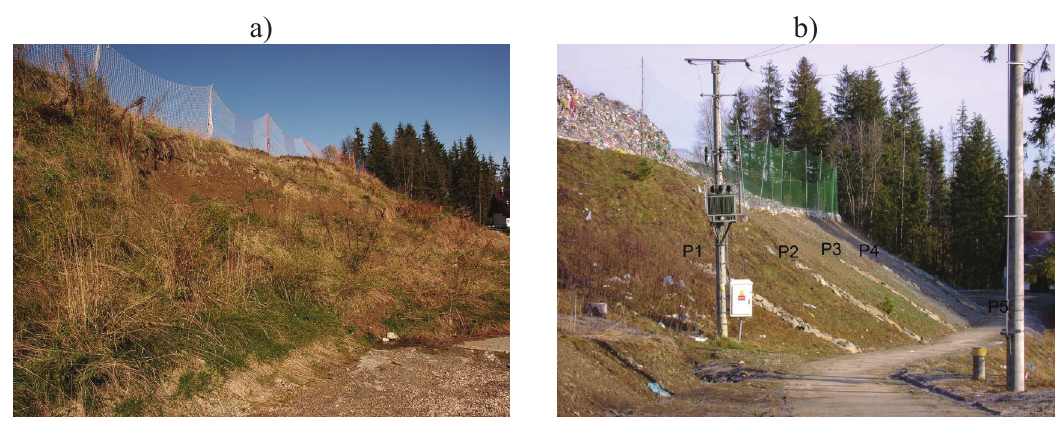
Figure 2 : Landfill retaining embankment: a) damaged, 2004, and b) after repairs with counterforts P1–P5,